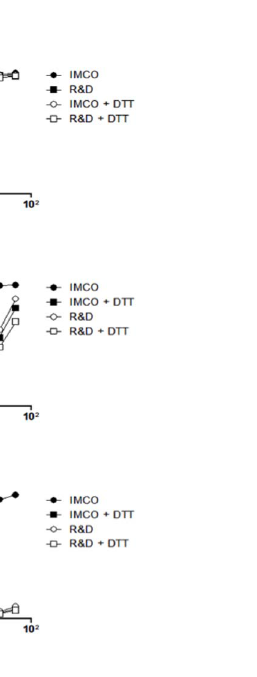
Figure 2. ELISA analysis of two different recombinant Trx1 by capture ELISA. Antibody combinations used for capture/detection were pAb/pAb (A) and mAb/pAb (B) and mAb/mAb (C). Trx1 standards were from IMCO and R&D. Both Trx1 standards were also analysed after being reduced by DTT. Data shown is from one of three experiments with consistent results.